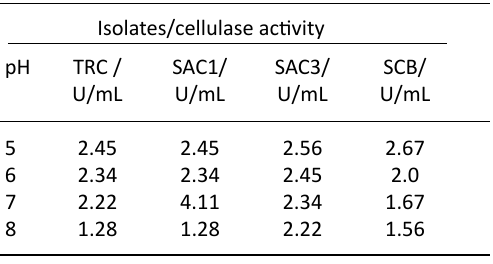
table 2. Consequence of varying temperatures on cellulase